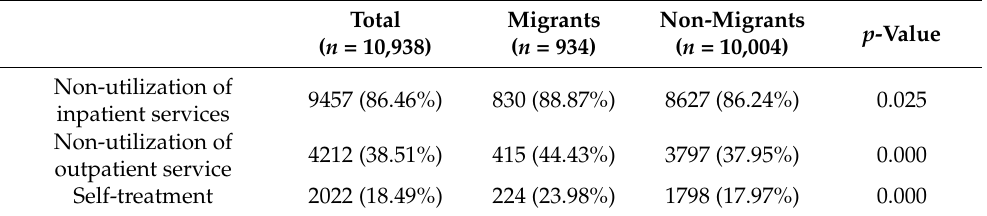
Table 3. The prevalence of unmet healthcare needs of unwell migrants and non-migrants in Shanghai.